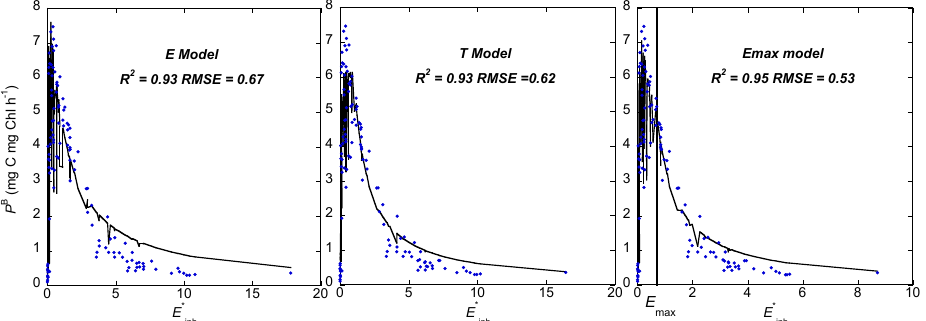
Figure 3. Observed (points) and fitted (lines) biomass-specific photosynthesis (mgCmgChlh − 1 ) as a function of UV+PAR exposure weighted by a spectral biological weighting function for inhibition, E ∗ (dimensionless). The panels illustrate the observed vs. fitted results inh for three BWF/P-E models, the E (left), T (center) and E max (right) models. RMSE is in mgCmgChl − 1 h − 1 . The fitted value for E max is shown by the vertical line in the panel on the right. Observations are for an exposure in the photoinhibitron of a HL 26 ◦ C culture of WH8102 (same as Fig. 2).